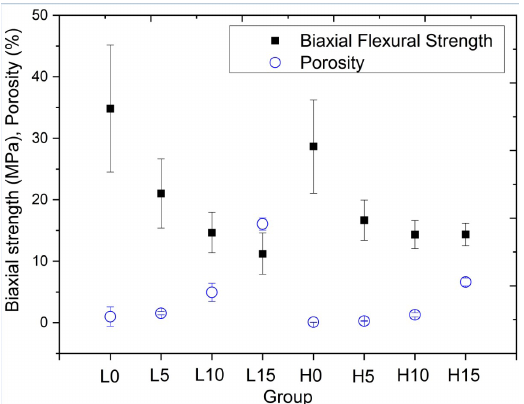
Figure 5. Biaxial flexural strength and porosity at 700 (L) and 800 ºC (H) for 0, 5, 10, and 15 wt% Nb